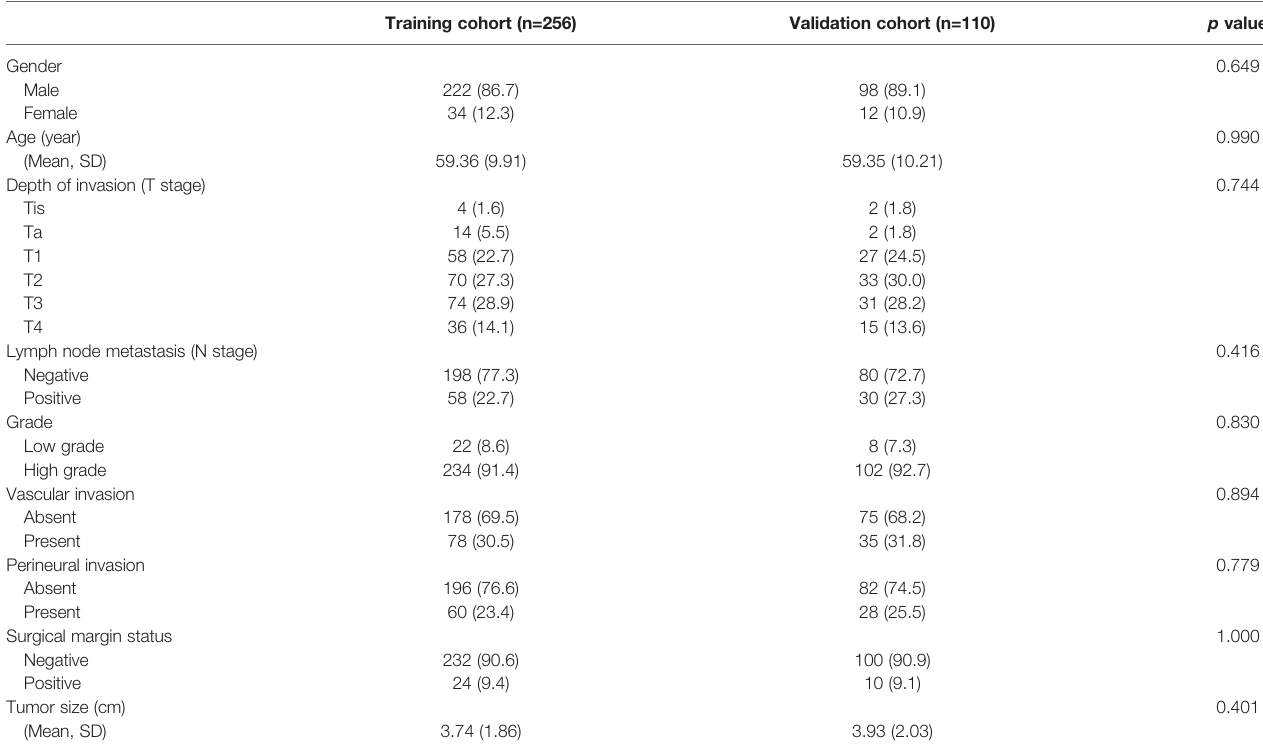
TABLE 1 | Demographic and clinical characteristics of patients in discovery and validation